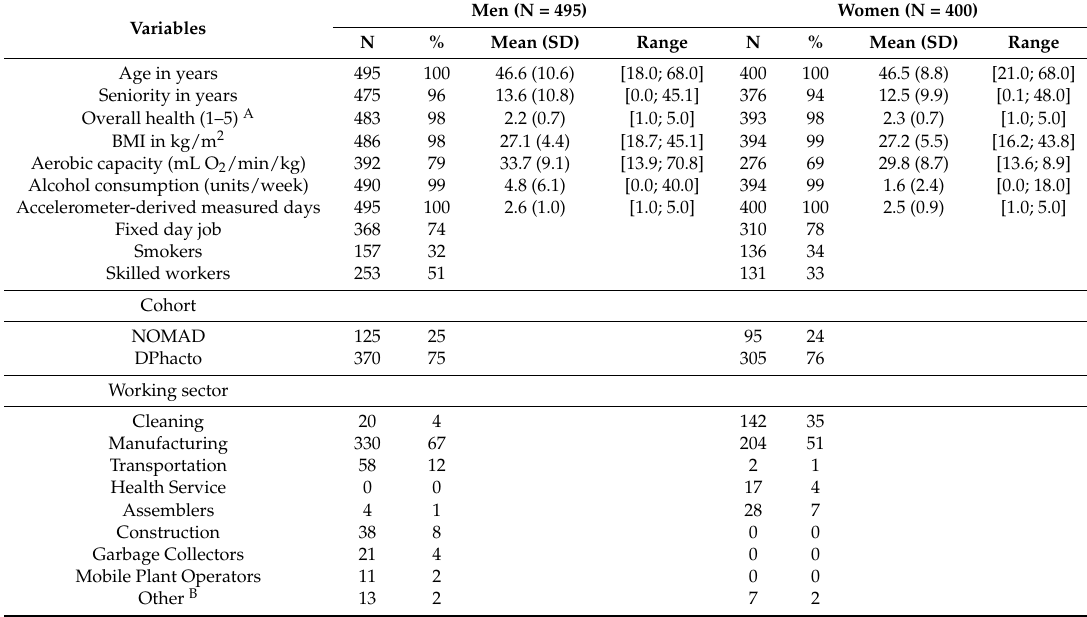
Figure 1. Flowchart of participants in the NOMAD and DPhacto study included in the current paper. NOMAD: New Method for Objective Measurements of Physical Activity in Daily Living; DPhacto: Danish PHysical ACTivity cohort with Objective measurements. Table 1. Baseline characteristics of the study population, stratified on sex.